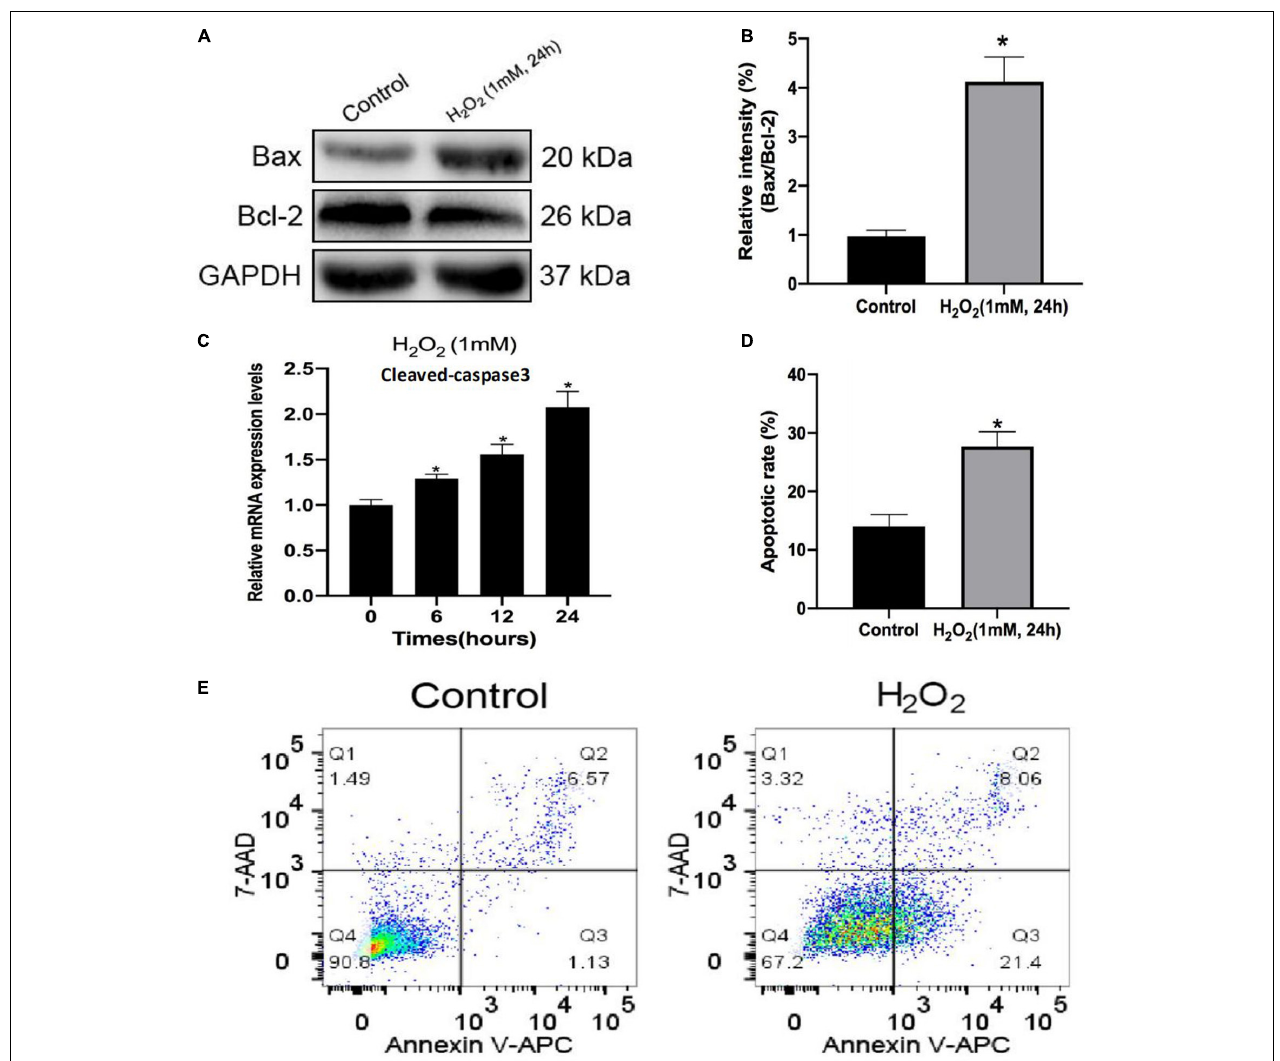
FIGURE 2 | Hydrogen peroxide promotes apoptosis in rat nucleus pulposus (NP) cells. (A,B) The protein levels of Bax and Bcl-2 in NP cells were measured by Western blotting. (C) Relative mRNA expression of cleaved caspase-3 by RT-qPCR. (D,E) Apoptosis of NP cells with or without H 2 O 2 treatment was detected by flow cytometry. Data are represented as the mean ± SD. * p < 0.05 vs. control